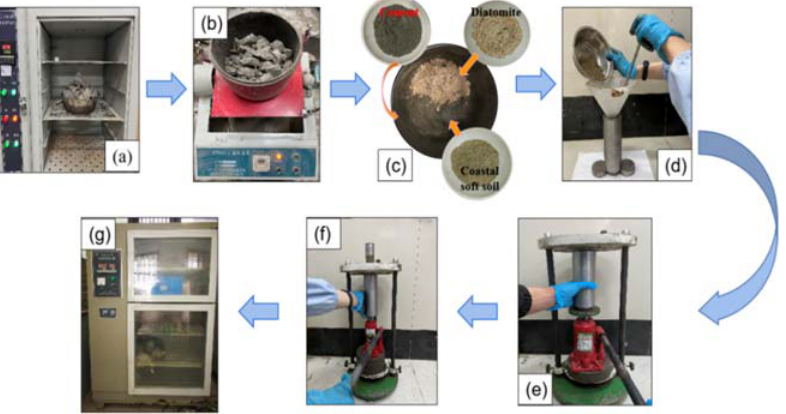
Figure 3. Standard specimen preparation diagram. (a–g). (a) is the drying soil in the process of sample preparation. (b) is the soil broken by the pulverizer during sample preparation. (c) is a mixture prepared during sample preparation. (d) shows the process of adding the mixture to the mold during sample preparation. (e) is a hydrostatic die during sample preparation to shape the soil sample. (f) shows the sample being pushed out of the die using jack pressure during the sample preparation process. (g) shows that the sample is prepared and put into the curing box for curing.